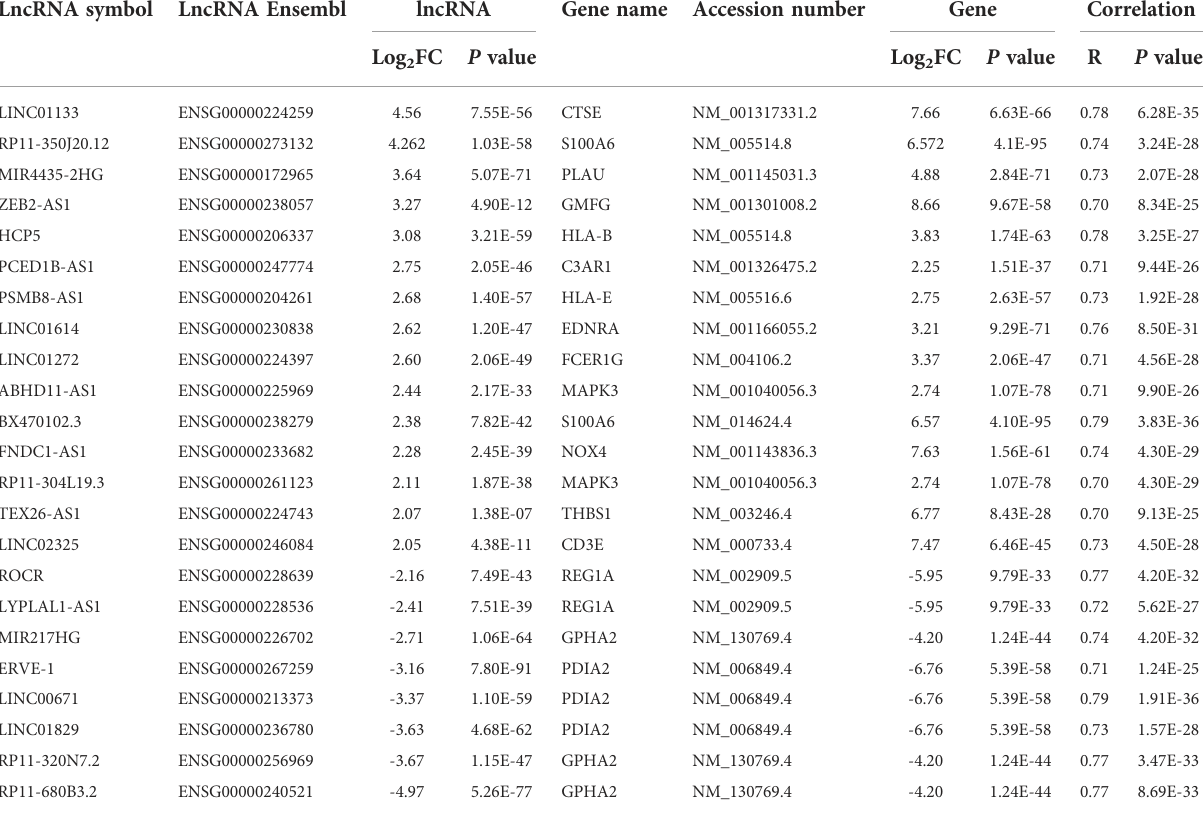
TABLE 1 Partial differentially expressed immune-related genes (IRGs) and immune-related lncRNAs (IRlncRNAs) in PaCa based on correlation